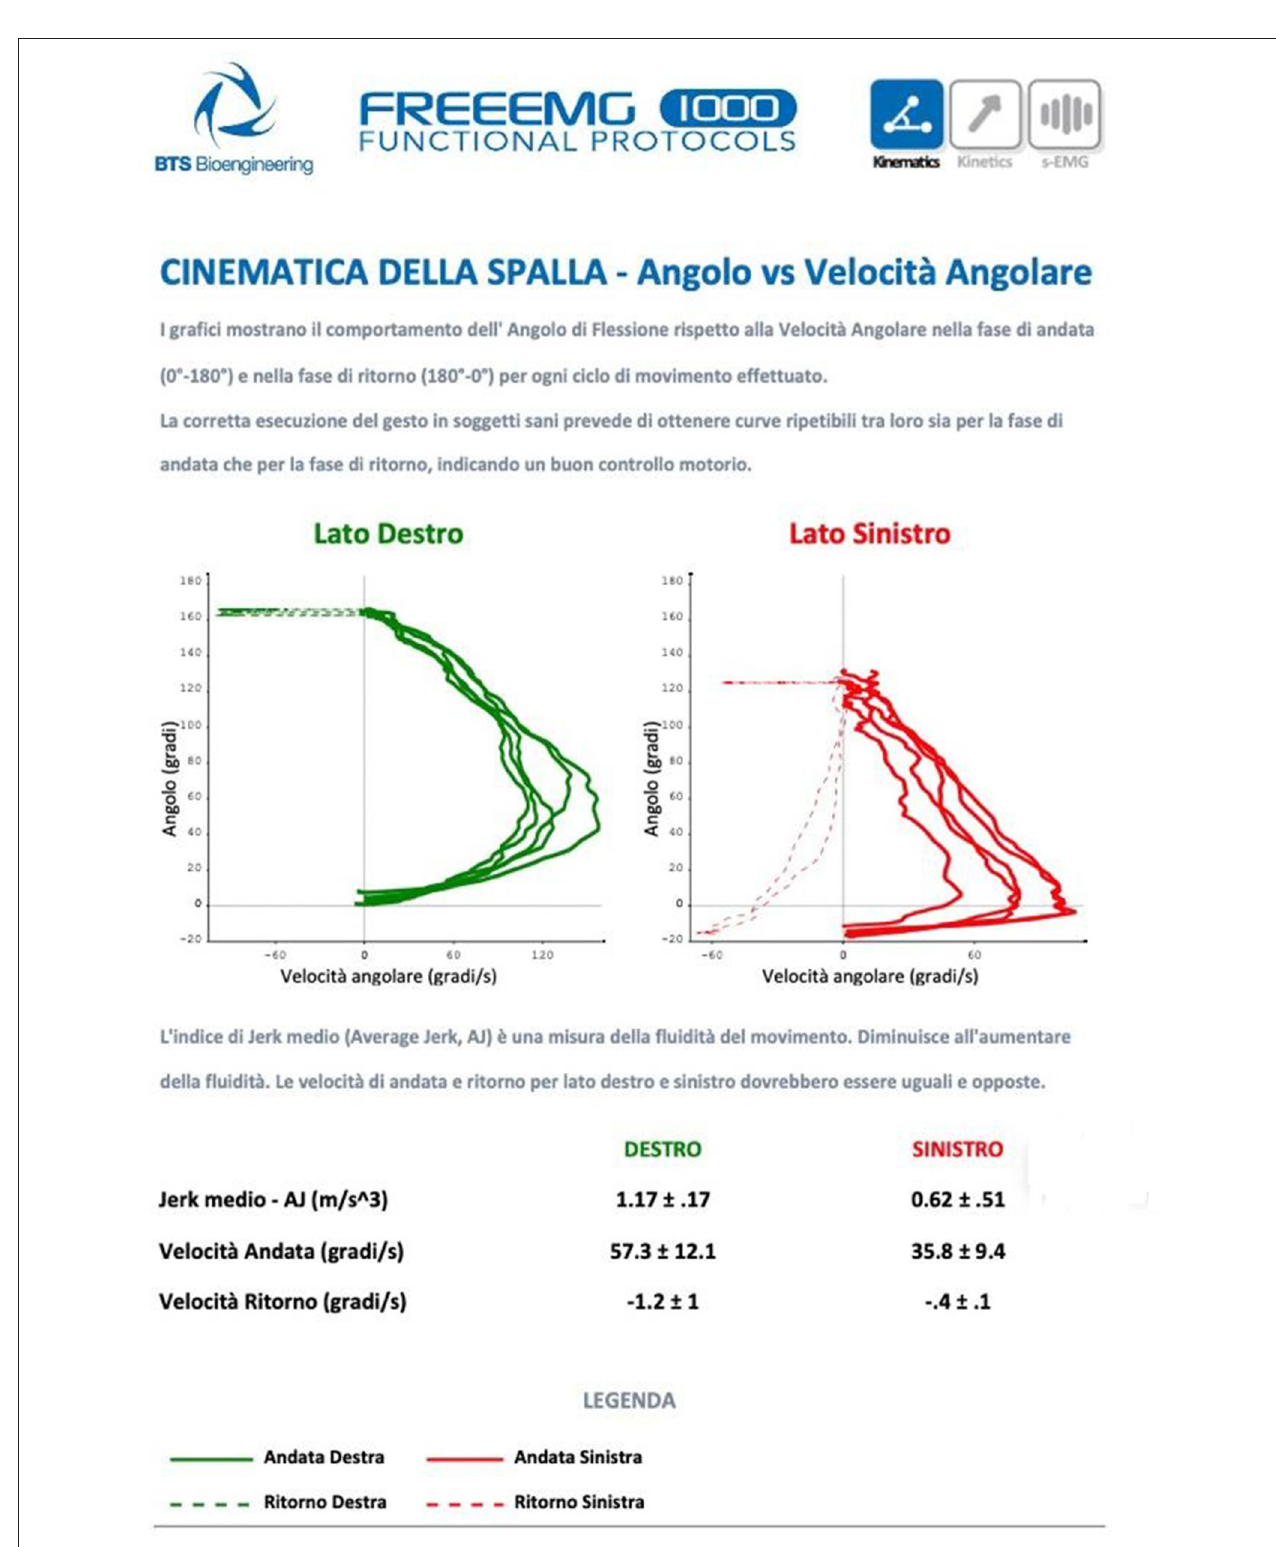
FIGURE 1 | The graphs show the behavior of the bending angle concerning the angular velocity in the outward and return phases for each cycle of movement performed. The correct execution of the gesture in healthy patients provides repeatable curves for both the outward and return phases, indicating good motor control.